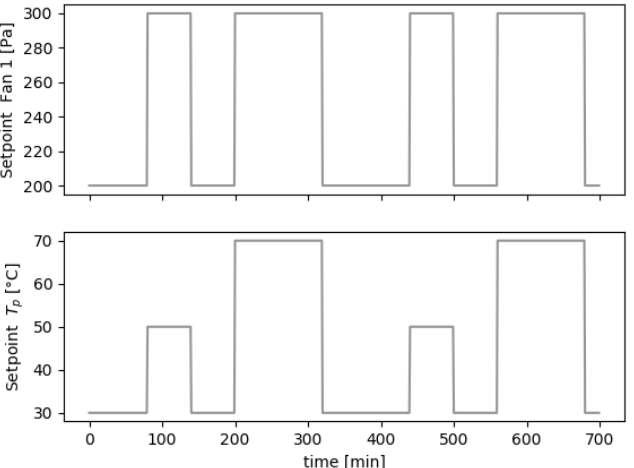
Figure 4. Setpoint for the ventilation unit “Fan 1” and the process temperature T p